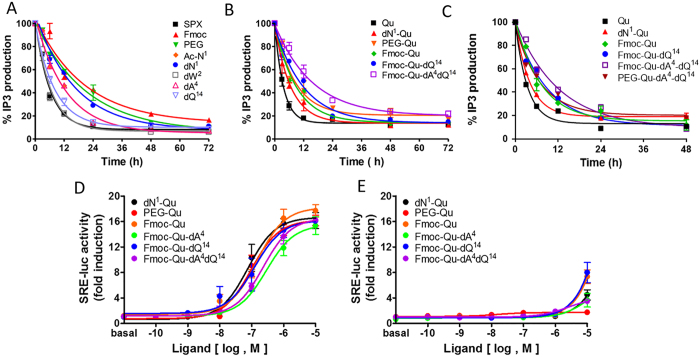
Stability of SPX mutants in the presence of FBS (A) Qu analogs in FBS (B) and human serum (C). Potency of Qu mutants toward GALR2 (D) and GALR3 (E). For stability of SPX mutants, peptides (1 μM) were incubated in serum for 0, 3, 6, 12, 24, 48, and 72 hrs. The remaining activities of the peptides were determined by measuring IP3 production by HEK293 cells that express GALR2 after the indicated times. IP3 production was expressed as percent change, where 100% indicates IP3 production by WT SPX incubated in FBS or human serum for 0 h. For potency of Qu mutants toward GALR2 and GALR3, the SRE-luc reporter vector and plasmid containing human GALR2 or GALR3 were transfected into HEK293 cells that stably expressed Gqi protein. Cells were then treated with increasing concentrations of mutant peptides, and the receptor activities were determined using the SRE-luc reporter system.